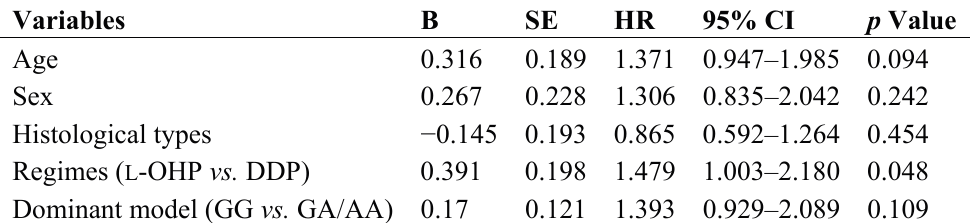
Table 5. Stepwise Cox regression analysis on the survival of gastric